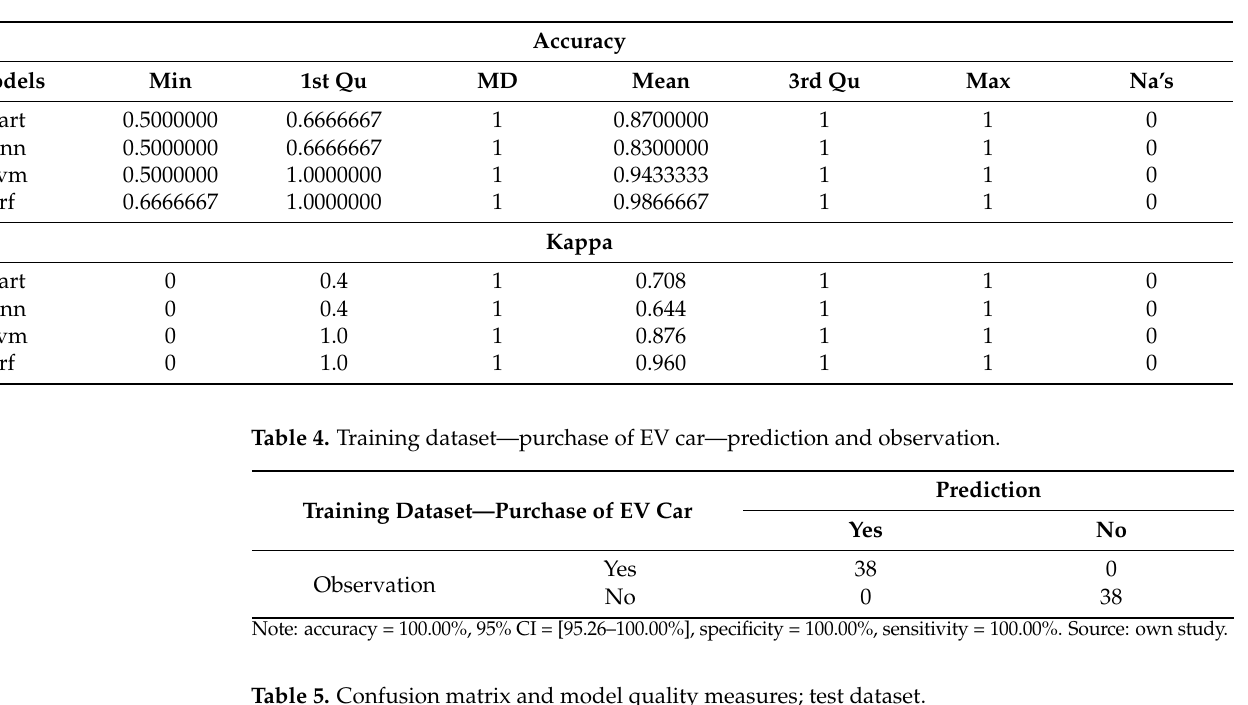
Table 5. Confusion matrix and model quality measures; test